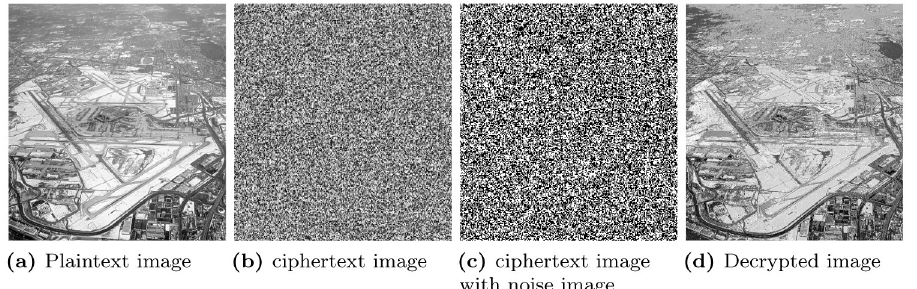
Fig 11. Noise attack analysis. (a) Plaintext image, (b) ciphertext image, (c) ciphertext image with noise image, and (d) Decrypted